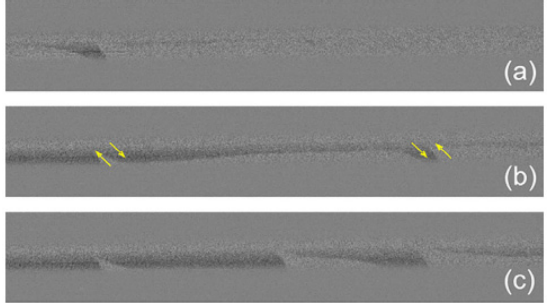
Figure 4. Axial magnetic field transformation of surface magnetic domain structure (H CIRC DC 1.12 Oe) ( a ) H AX = 2.75 Oe; ( b ) H AX = 2.8 Oe; ( c ) H AX = 2.85 Oe. Image size is 150 × 720 µm 2 . Reprinted with